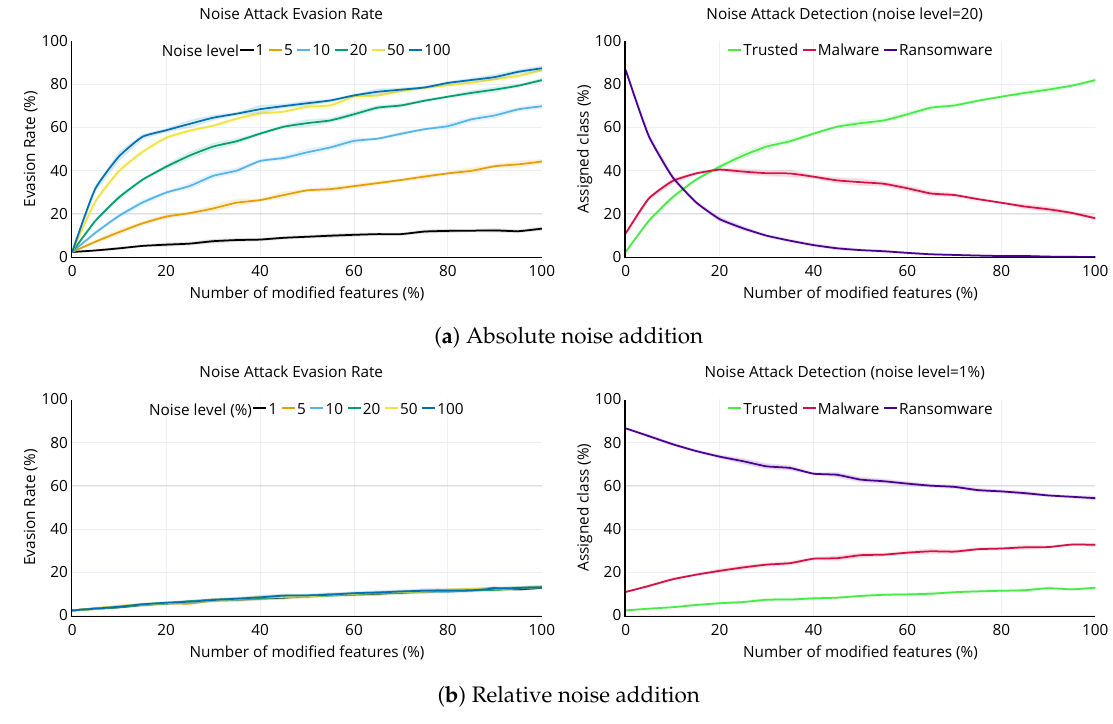
Figure 9. Evasion rate for different levels of noise injection in the absolute and relative cases (left side of Figure 9a,b, respectively). Detection detail for a noise level equal to 20 (right side of Figure 9a) and a 1% noise level (right side of Figure 9b). All the results are the average over five repetitions and include the standard deviation in translucent